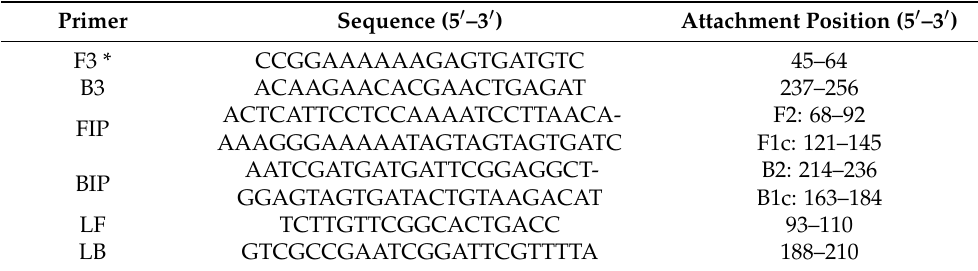
Table 3. LAMP primers used for TMV detection.